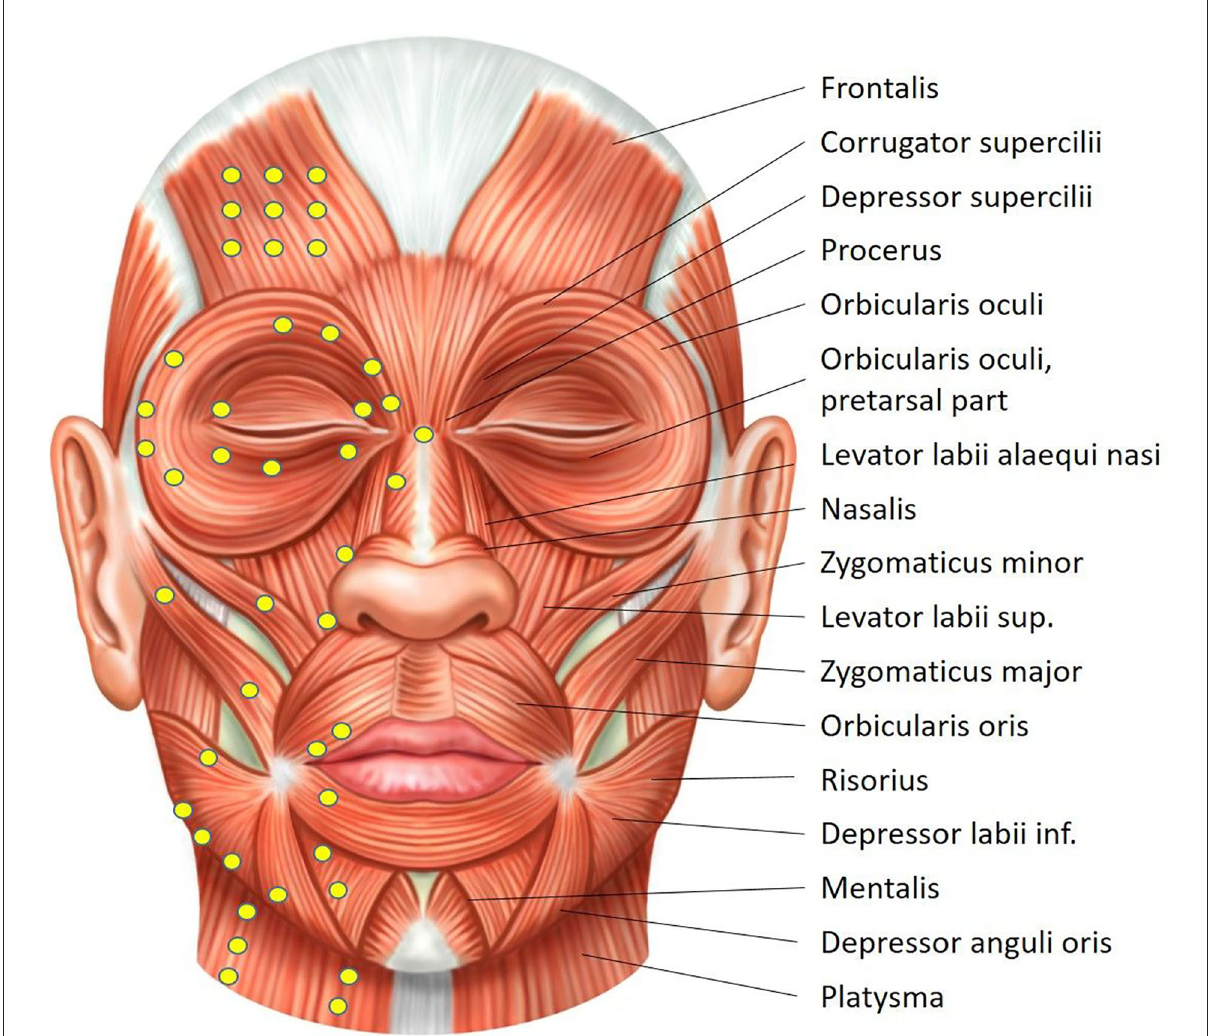
FIGURE4 Overview of the facial muscles. Typical injection sites are displayed on the right hemiface. Drawing by Sonja Burger.